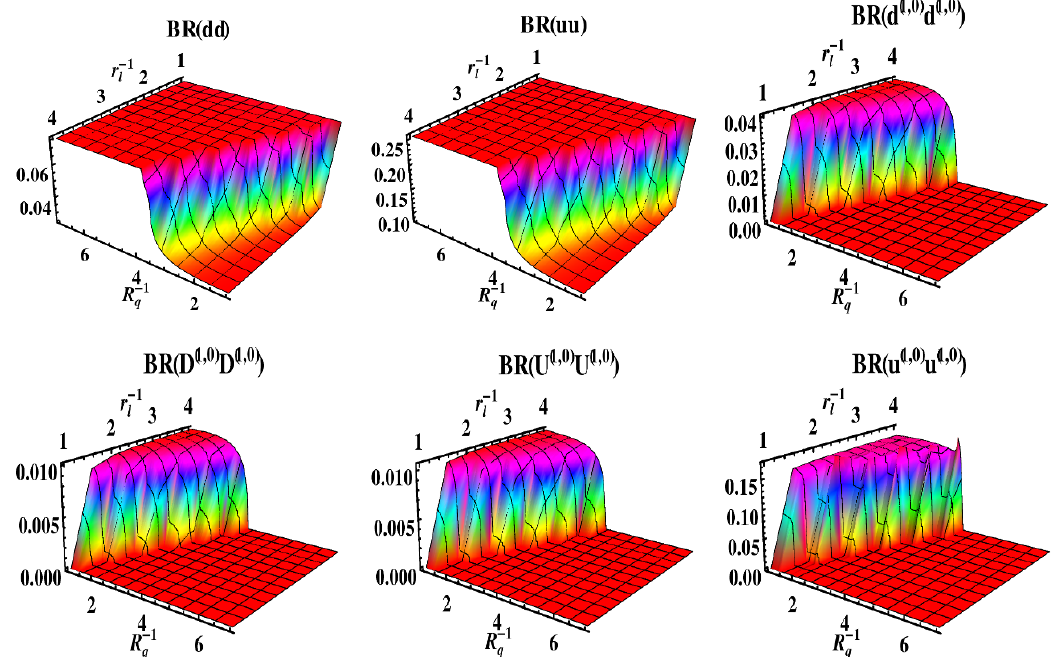
Figure 4 . Branching ratios of B (0 ; 2) for down-type(d) and up-type quarks(u) as the (cid:12)nal states. The quark singlets and doublets are represented by d and D respectively. (cid:3) R = 20 has been assumed in the